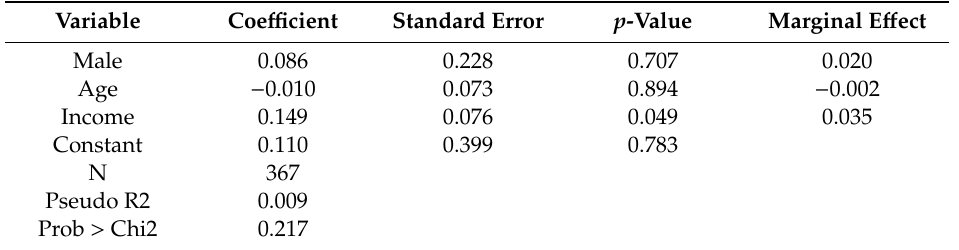
Table 10. Logit model results predicting likelihood to seek veterinary care respondents who own or owned a cat (n =